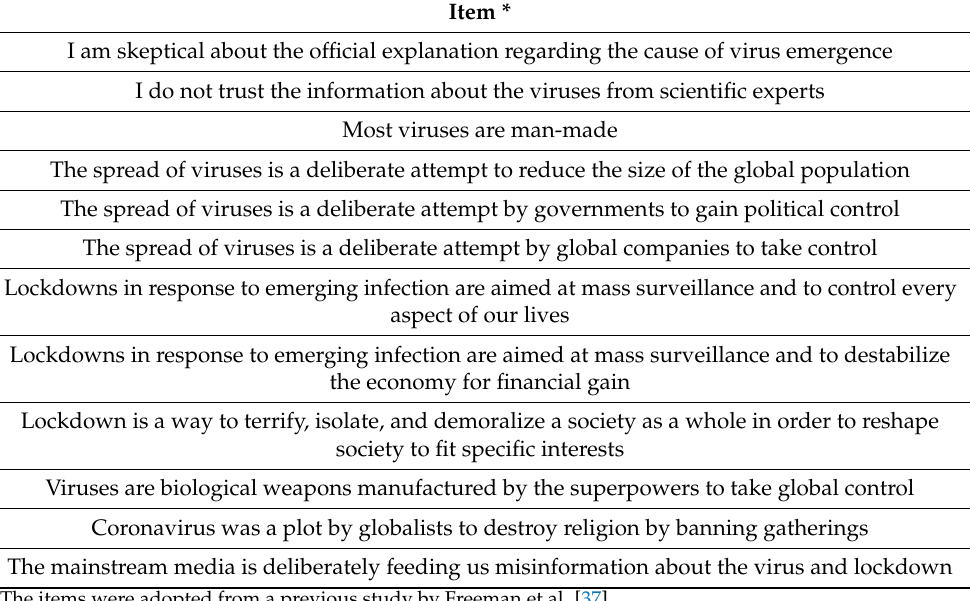
Table 1. Items of the emerging virus infections conspiracy scale